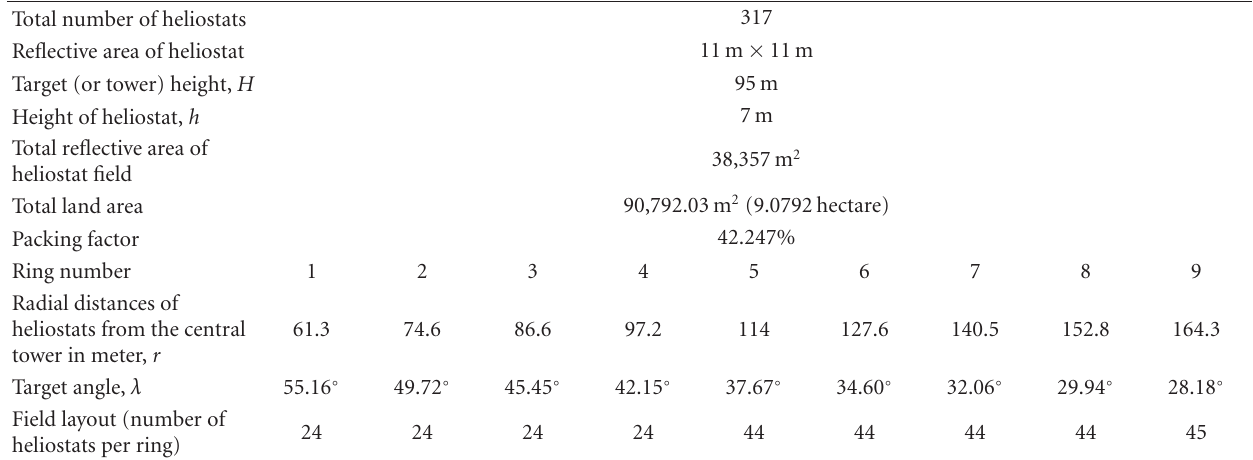
Table 1: Specification of central power tower and heliostat field